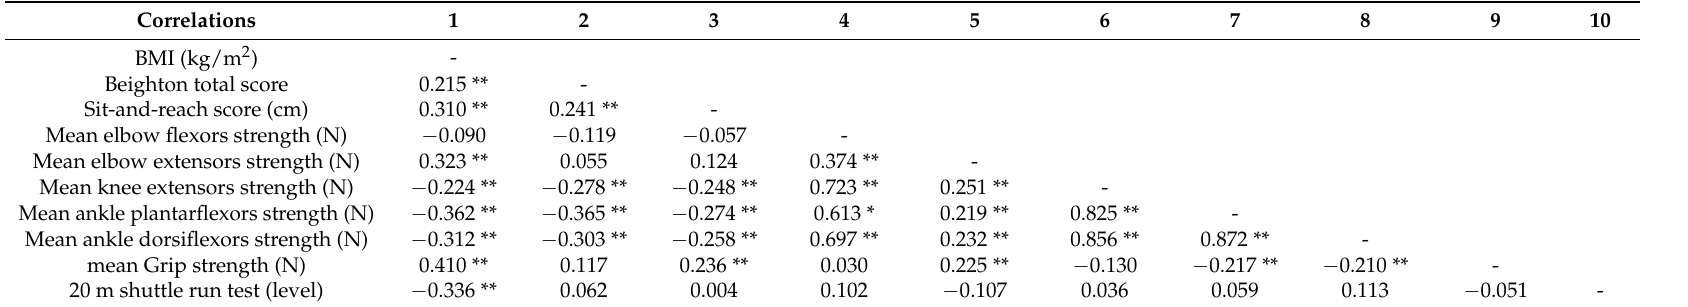
Table 5. Pearson Correlation matrix for body mass index, cardiorespiratory fitness, and measures of musculoskeletal fitness.